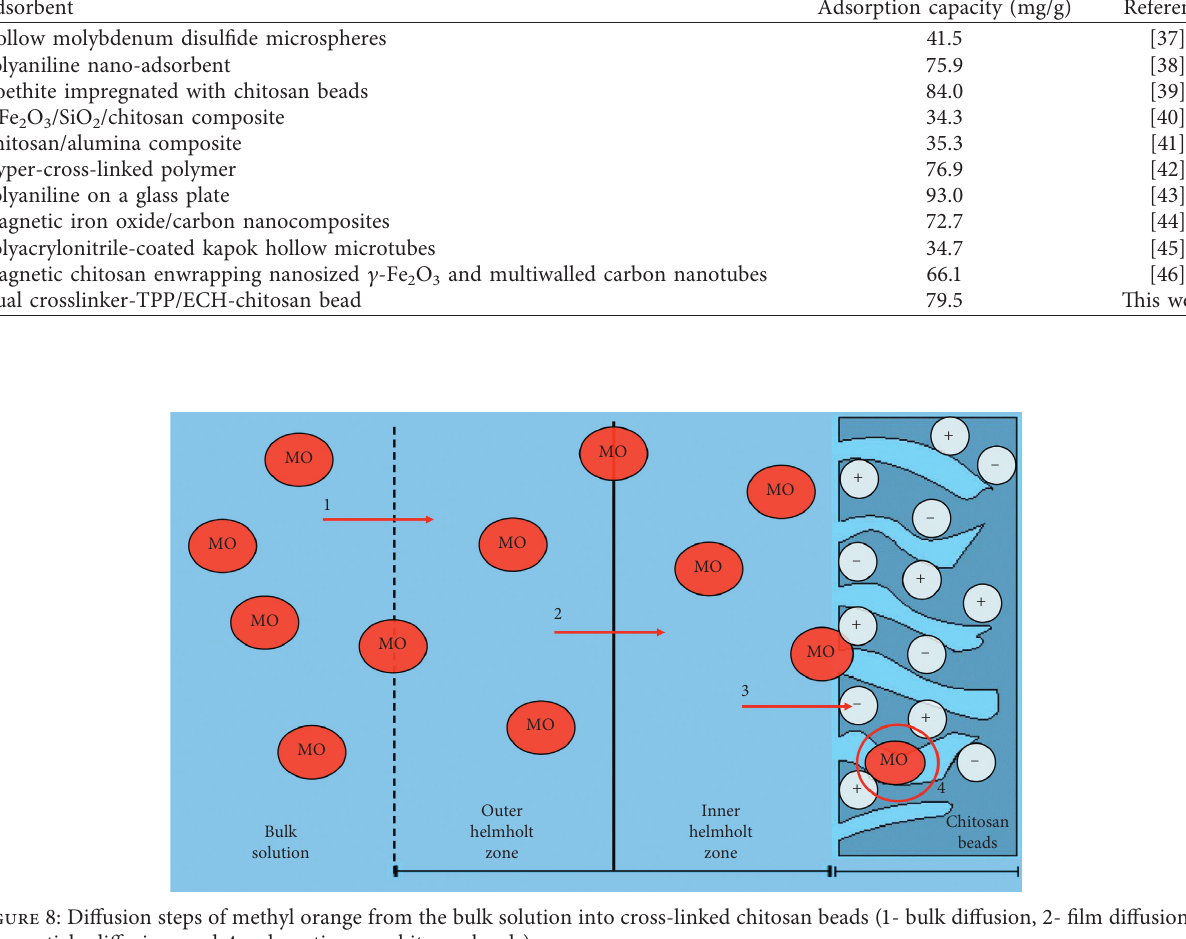
Table 1: Adsorption capacities of several adsorbents for the methyl orange adsorption. Adsorbent